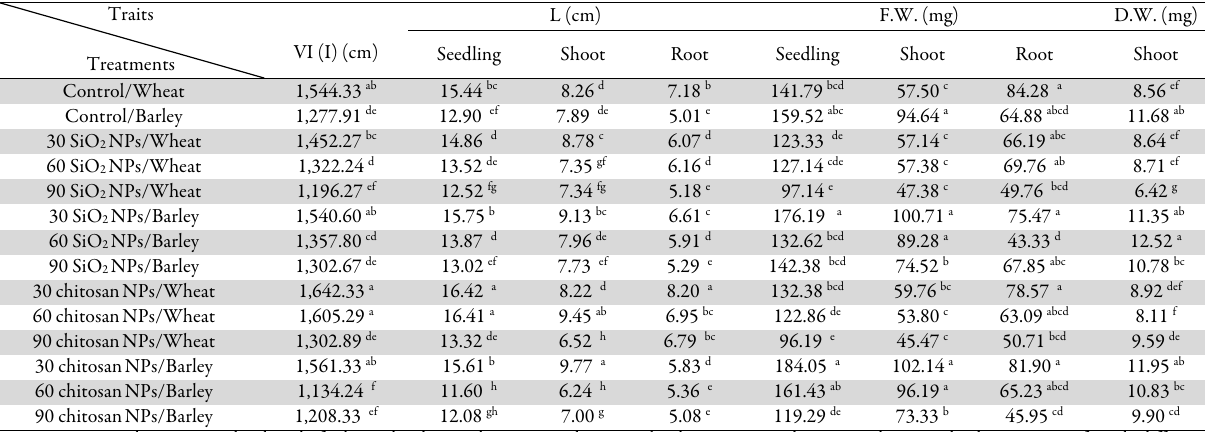
Table 2. Effects of SiO 2 and chitosan NPs on wheat and barley growth parameters